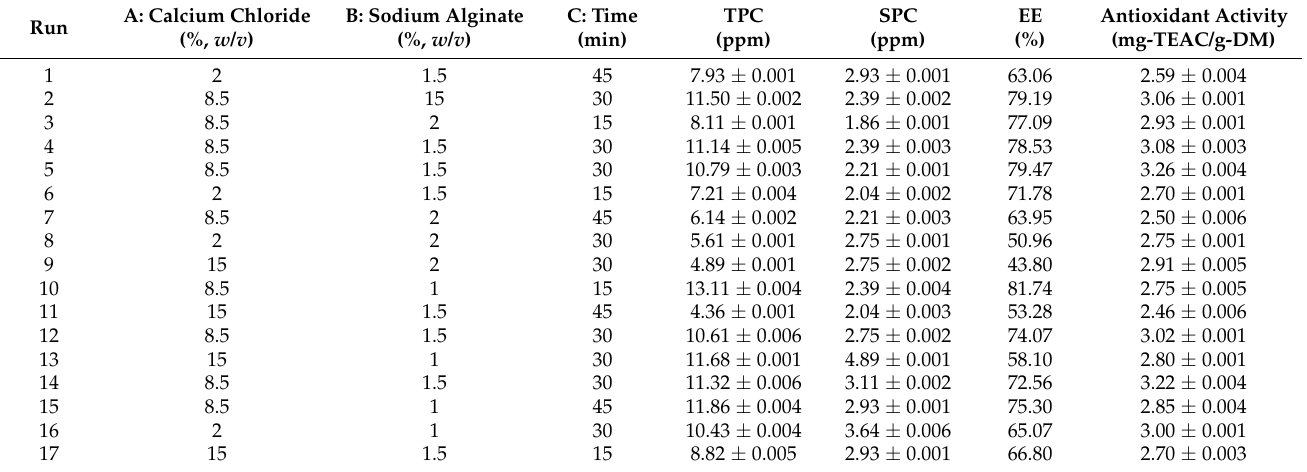
Table 2. Experimental results for the microencapsulation of active substances in sour cherry peels according to Box-Behnken design of